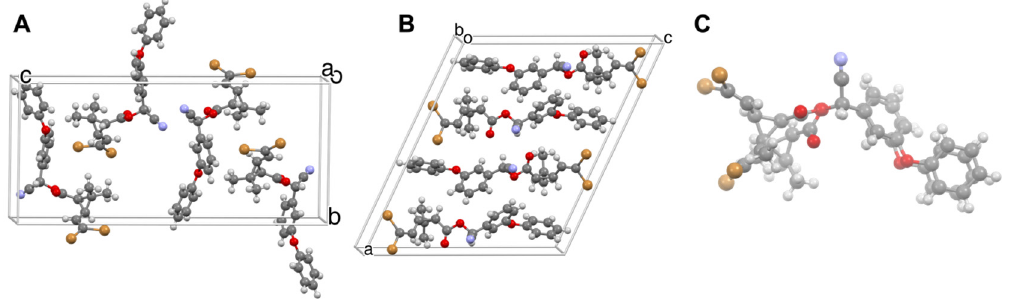
Figure 1. ( A ) Single-crystal structure of DM Form I. ( B ) Single-crystal structure of DM Form II. ( C ) The conformations of DM in Forms I and II overlaid, illustrating distinct molecular conformations in the polymorphs. The crystal structure of Form II was reported for the first time by our laboratory [1]. The crystal structure of DM Form I, redetermined by our laboratory is identical to that previously reported [19].